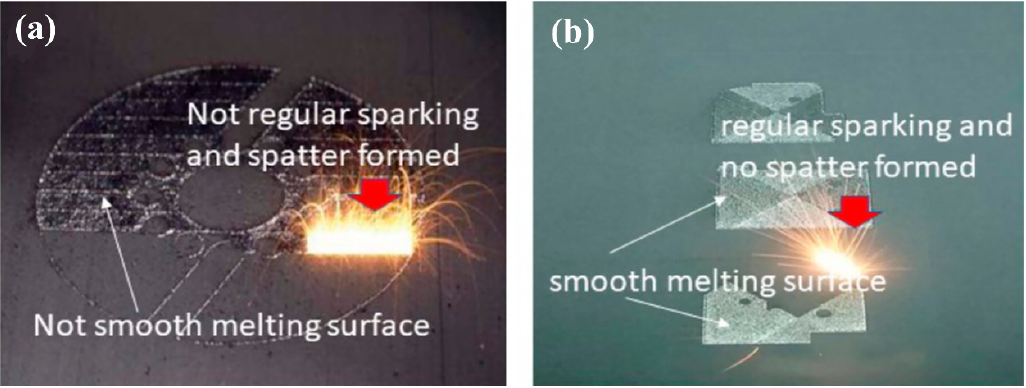
Figure 12. Surface morphology and sparking of two typical SLM fabrication processes: ( a ) rough surface without regular sparking and spatter formed; ( b ) fine surface with regular sparking and no spatter formed.